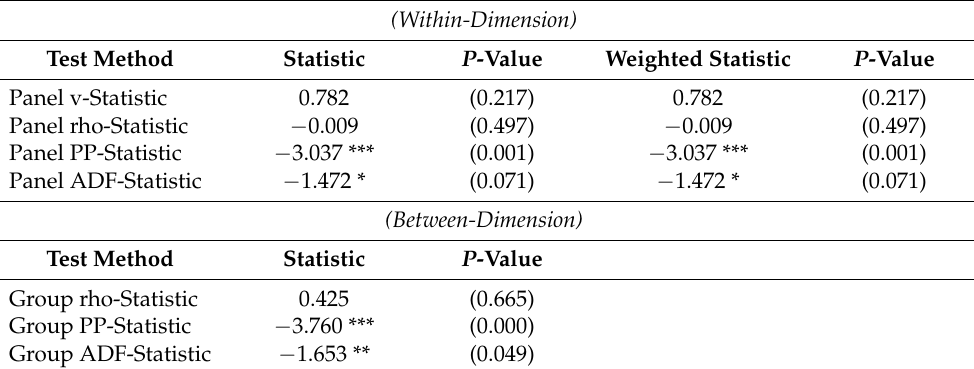
Table 5. Pedroni Cointegration Test.